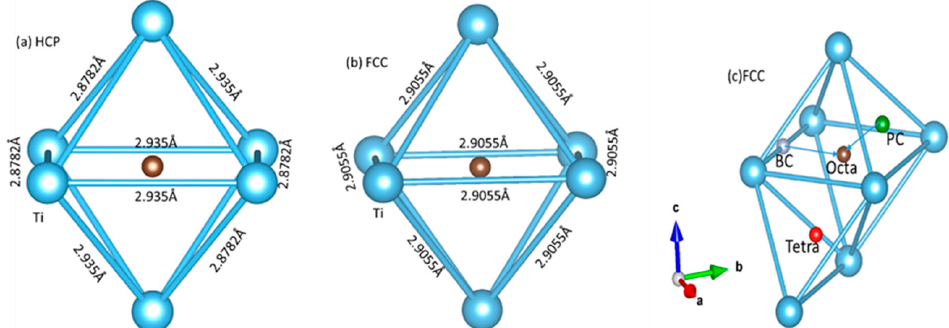
Figure 1. ( a , b ) Schematic diagrams of the octahedral interstitial sites in HCP-Ti and FCC-Ti, respectively. ( c ) Interstitial sites in